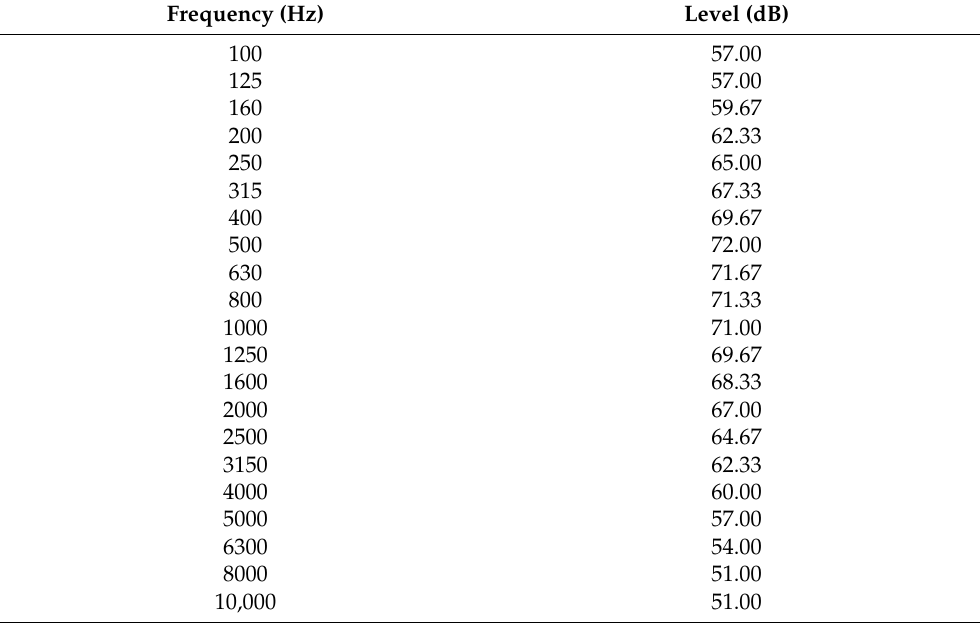
Table 9. Sound source characteristics from EASE Loudspeakers Database